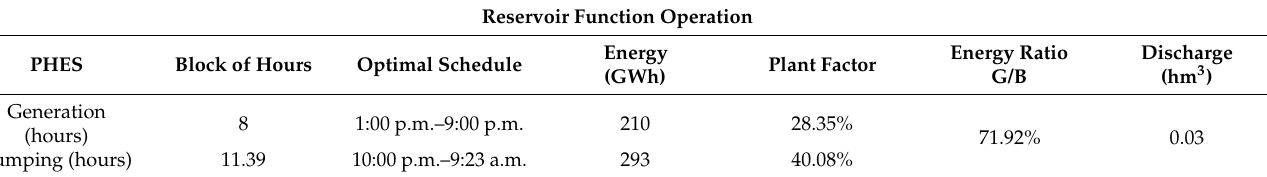
Table 12. Results of the reservoir function operation.